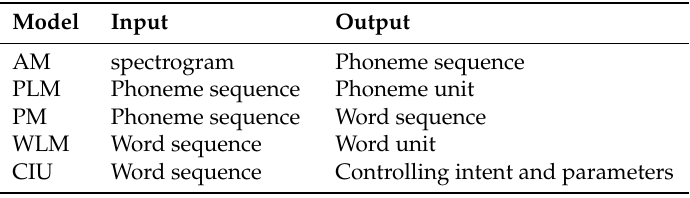
Table 3. Input and output of the proposed